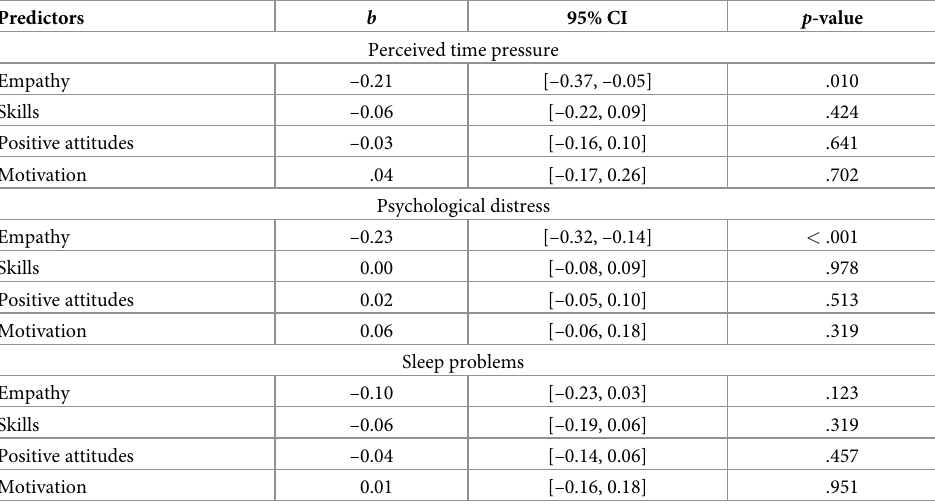
All models adjusted for gender, age, employment sector, and frequency of interacting with patients and colleagues from different cultures. b = unstandardized regression coefficient; CI = confidence